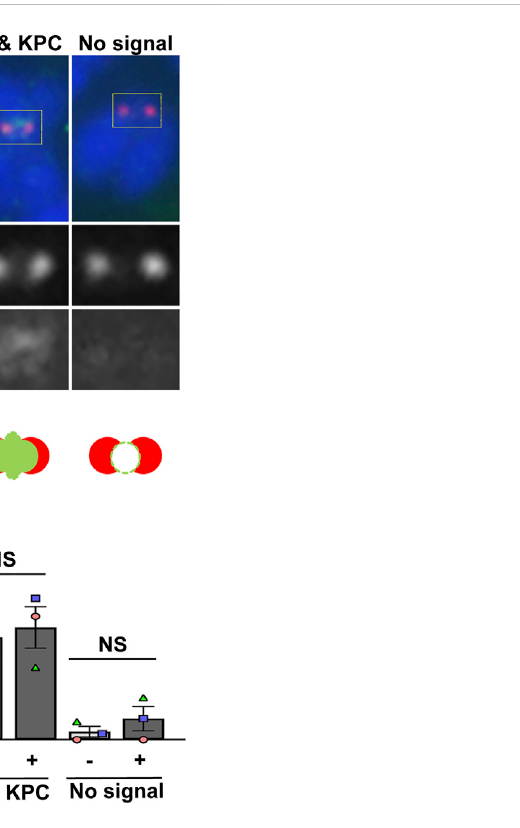
FIGURE 3 EWSR1 contributes to for Aurora B localization at inner centromere, and prevents its localization at kinetochore during early mitosis. (A) . Representative images of Aurora B on pro/metaphase chromosome obtained from control (AUX-) cells that were released from thymidine/nocodazole for 30 min. The Aurora B (Green, top and bottom panel) and CENP-C (kinetochore marker) (Red, top and middle panel) were visualized by immunocytochemistry using anti- Aurora B and anti-CENP-C antibodies. Classi fi cation of the localization of Aurora B; Inner Centromere (IC), Kinetochore Proximal Centromere (KPC), Inner Centromere and Kinetochore Proximal Centromere (IC + KPC), and No Signal. Scale bar = 10 um. (B) . Quanti fi cation of Aurora B localization at IC, KPC, IC + KPC, and No signal between AUX- and AUX + cells (total of 712 – 732 chromosomes per sample, n = 3 experiments). Values are mean with standard error of the mean (SEM). Two-tailed paired t-test; *p < 0.05, **p < 0.01, NS; Non-Signi fi